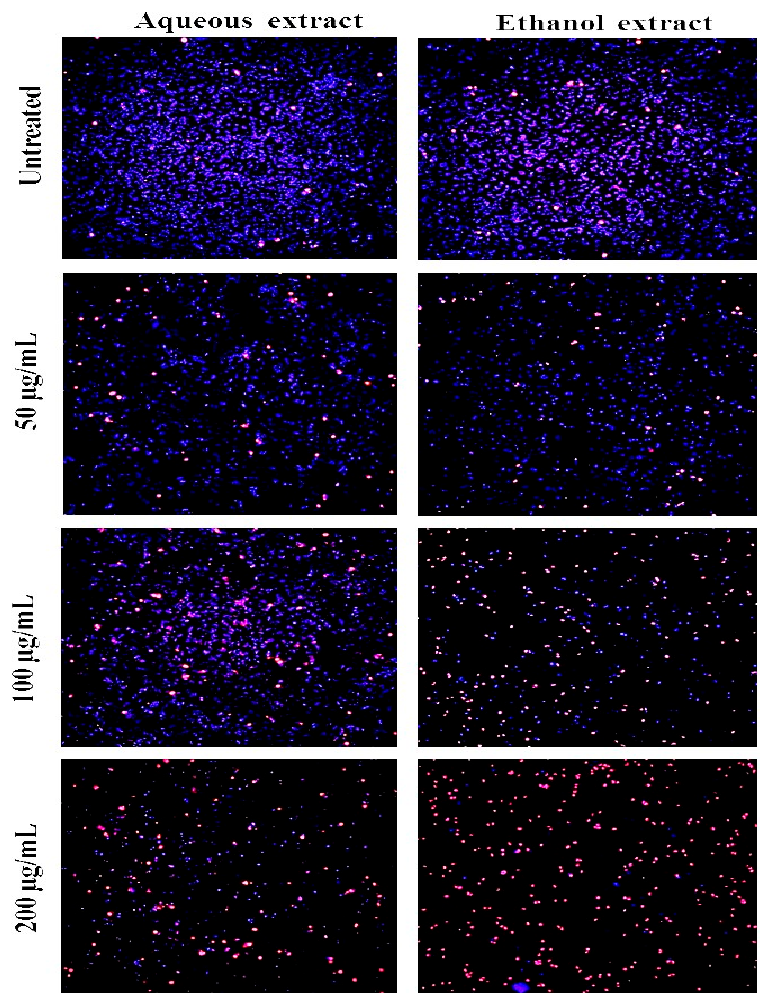
Figure 4. Representative images of aqueous and ethanolic extracts of V. mespilifolia at the varying concentrations on the HeLa cells after 48 h exposure using Hoechst 33,342 (blue) and propidium iodide (red) dual staining.